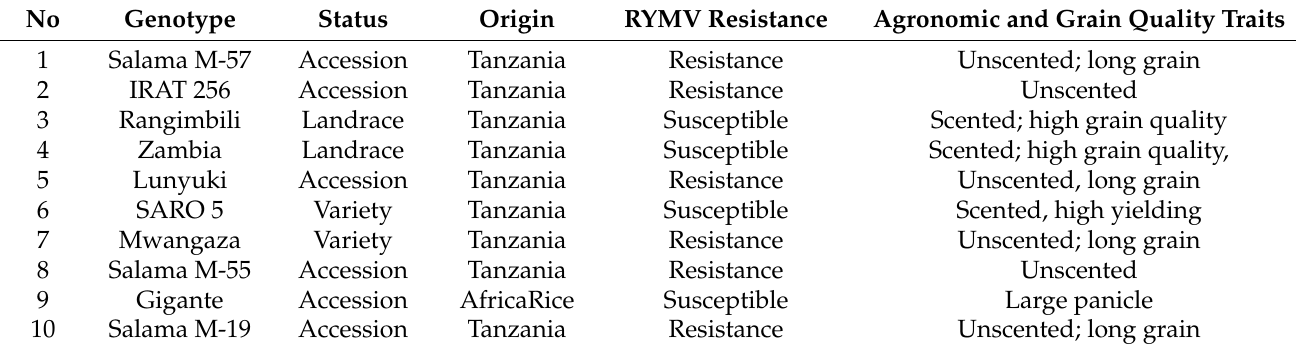
Table 1. Description of rice parental genotypes used for population